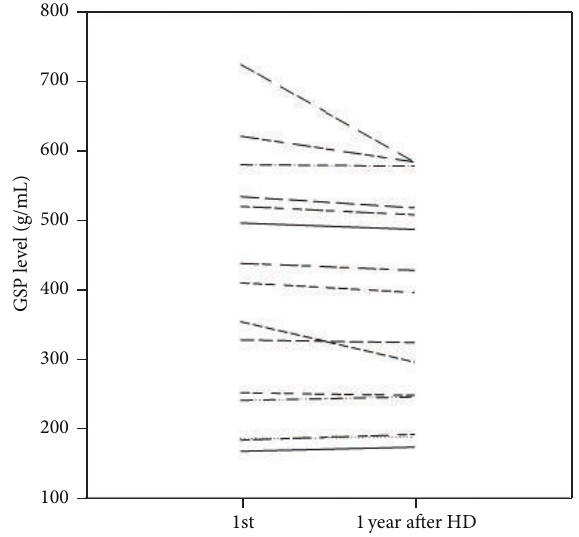
Figure 2: Of the 74 total patients, 14 were selected for comparison of galactose single-point (GSP) values (g/mL) before and after a single session of hemodialysis (HD). The average pre-HD and post-HD GSP values were 409.57 ± 256.12 g/mL and 438.86 ± 298.17 g/mL (corrected according to postdialysis hematocrit), respectively.